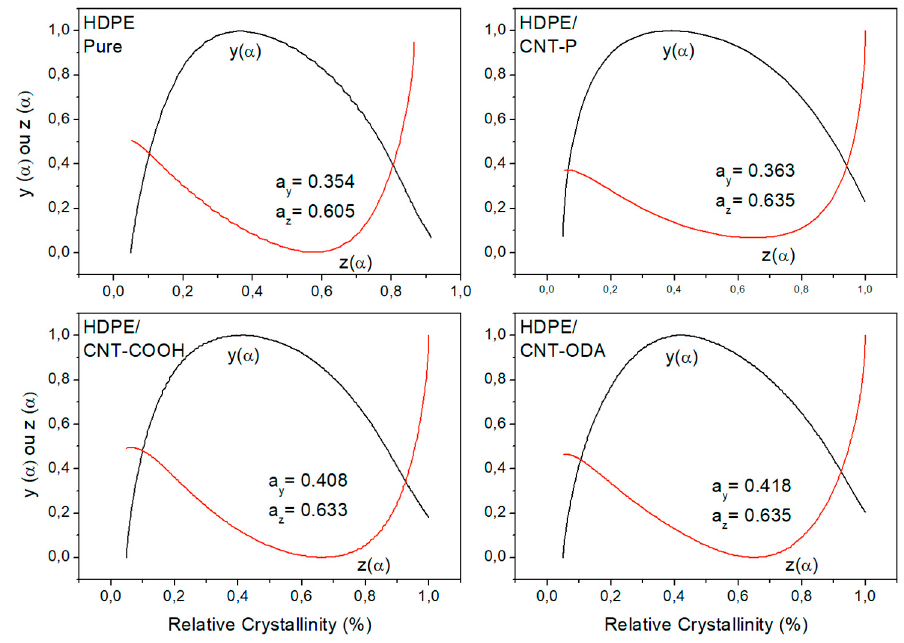
Figure 6. Experimental dependence of y ( α ) and z ( α ) versus α for pure HDPE and HDPE/CNT nanocomposites.